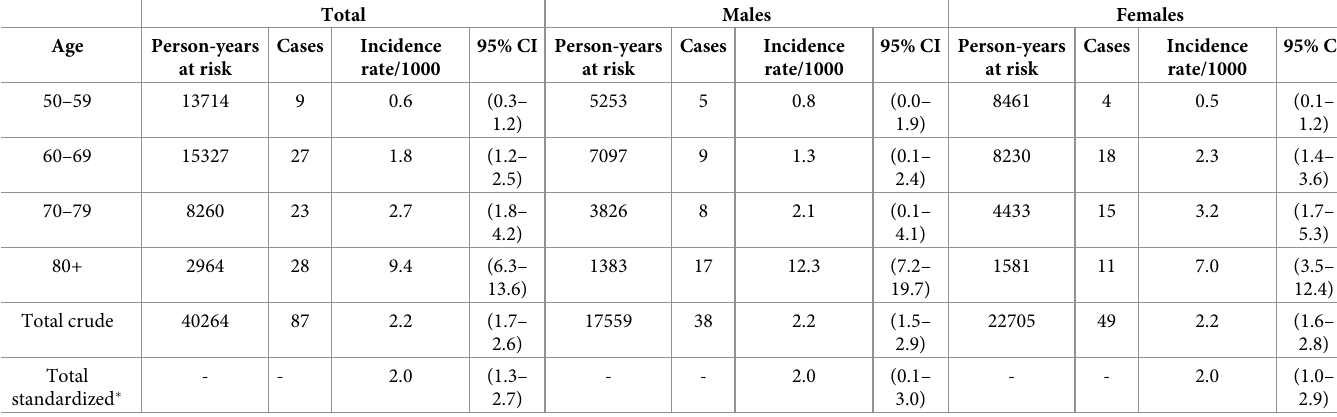
CI = confidence intervals; MHAS = Mexican Health and Aging Study. Values are weighted percentages (95% CI) derived using the MHAS sampling weights. � Standardized = age- and sex-standardized to the Mexican population